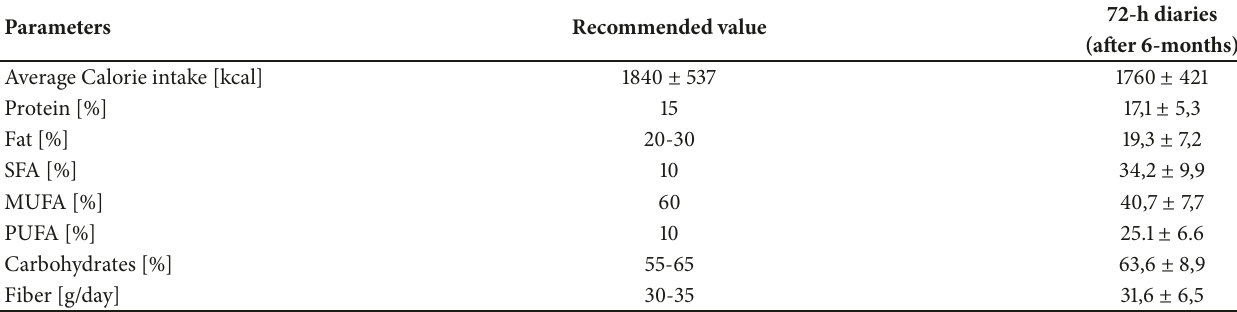
Table 1: Dietary recommendations and current consumption according to 72-h diaries.